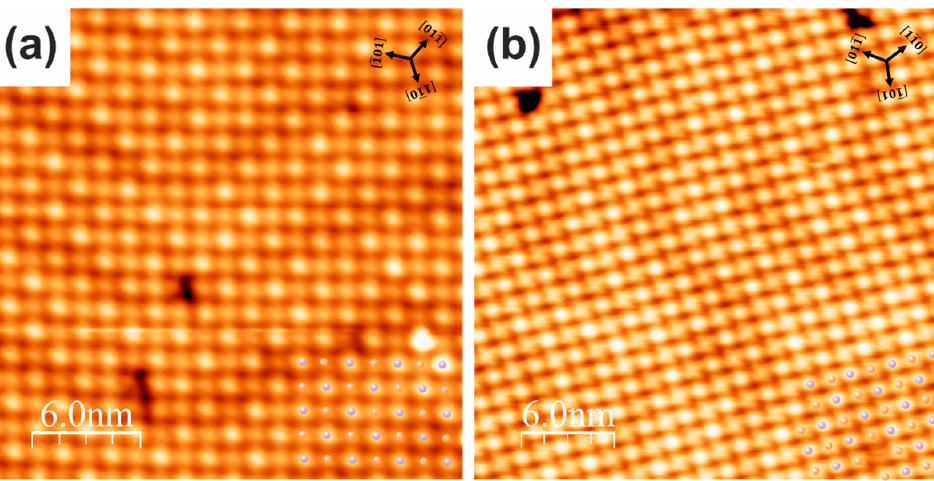
Figure 1. STM micrographs of the checkerboard assembly of MnPc and FeFPc molecules on Au(111). ( a ) 35 nm × 35 nm micrograph (U = 0.1 V, I = 5 pA) obtained upon subsequent deposition of the molecules. ( b ) 30 nm × 30 nm micrograph (U = − 2.2 V, I = 5 pA) obtained upon co-deposition of the molecules. Irrespective of the sequence of deposition steps we obtained the same checkerboard morphology with herringbone reconstruction still present. Colored circles in the bottom right corner of both images serve as a guide for the eye that illustrates the checkerboard pattern of Fe (orange) and Mn (violet) in the assembly.